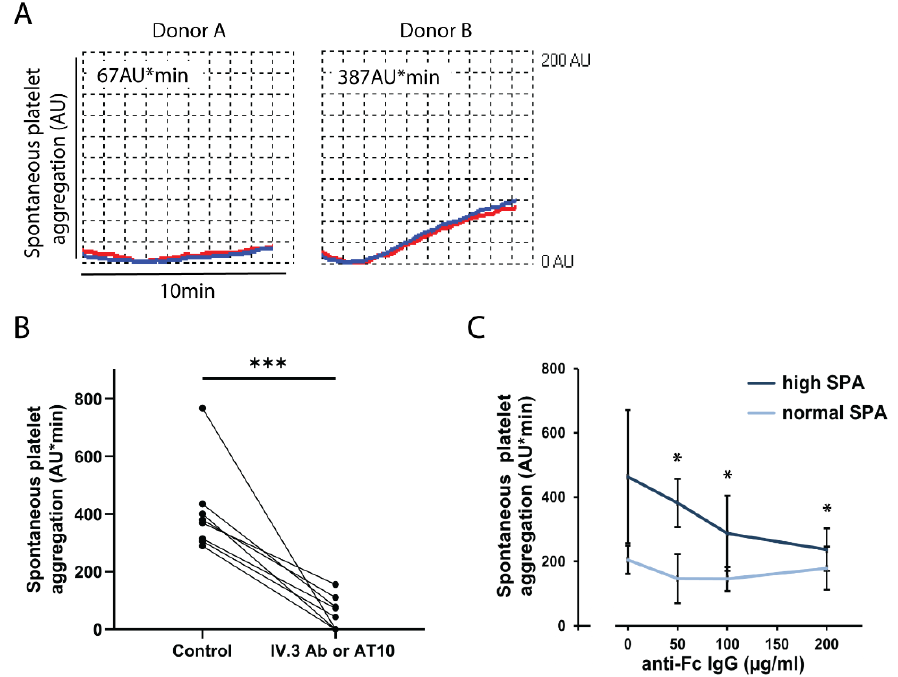
Figure 1. Increased spontaneous platelet aggregation (SPA) in blood is mediated by activation of Fc γ RIIA. ( A ) Normal and increased SPA in blood from donor A and B, respectively. The antico- agulated blood samples were prewarmed for 3 min without stirring at 37 °C. The stirrer was then added, and the measurement was started. Platelet aggregation was measured for 10 min by MEA. Representative tracings recorded by the two electrode pairs (blue, red) are shown. Increased SPA in donor B begins after 2 min. ( B ) Inhibition of increased SPA by the anti-Fc γ RIIA antibody IV.3 or AT10. Blood samples from subjects ( n = 8) with increased SPA (289-767 AU*min) were incubated for 3 min without (control) or with the CD32 antibody IV.3 or AT10 (2 µg/mL), and then stirred for 10 min. The values are means ± SD ( n = 8). *** p < 0.001. C. Effects of anti-human Fc-IgG antibody on SPA. Blood samples from donors with increased SPA (>250 AU*min, n = 4) and normal SPA (<250 AU*min, n = 4) were pre-incubated for 3 min with different concentrations (50, 100 and 200 µg/mL) of a goat antibody (IgG) directed against the Fc part of human IgG. Then, stirring and measure- ments (10 min) were started. The values are means ± SD ( n = 4). * p < 0.05 compared to the samples without Fc-IgG antibodies.